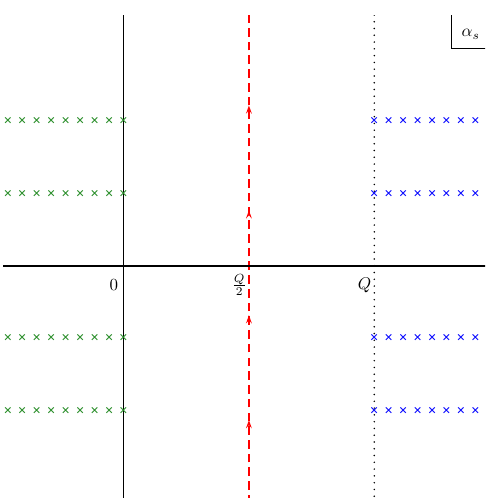
Q ), the 1 + (cid:11) 2 ) > 2